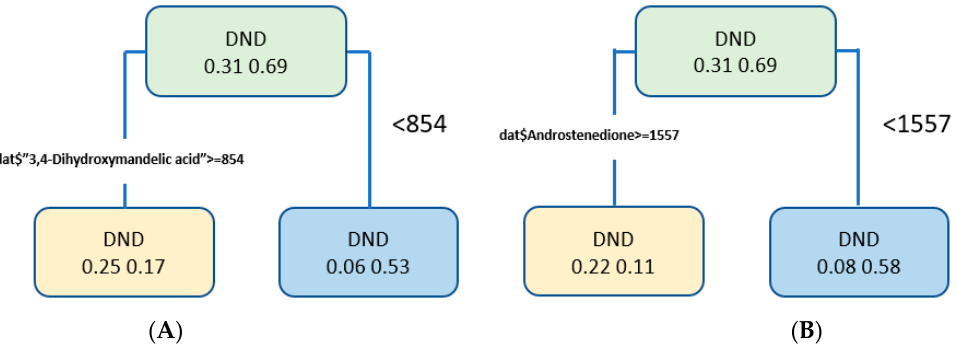
Figure 4. Decision tree plots: ( A ) Decision tree plot for the clinically confirmed diabetes data; ( B ) decision tree plot for the HbA1c